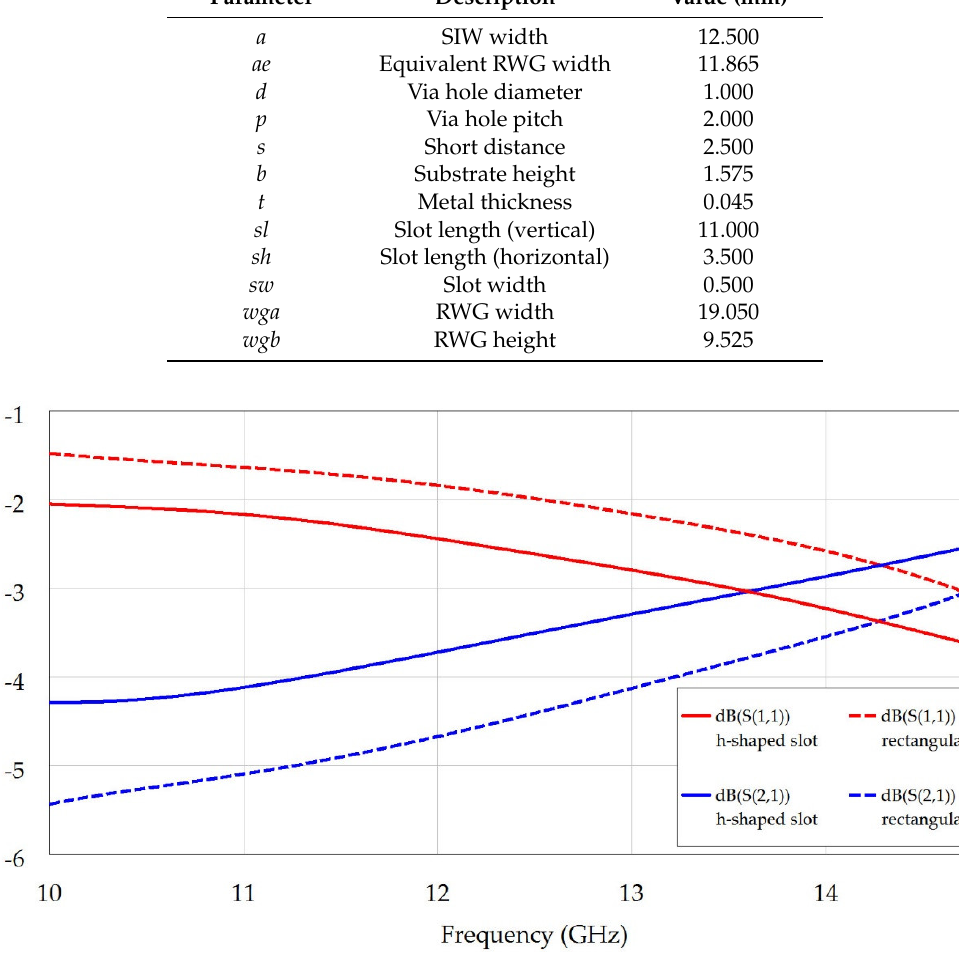
Figure 2. RWG-to-SIW transition simulated scattering parameters (no matching elements).